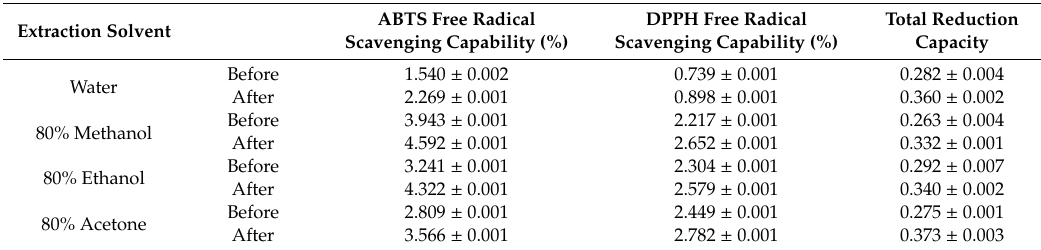
Table 8. The antioxidant activities of G. biloba leaves before and after